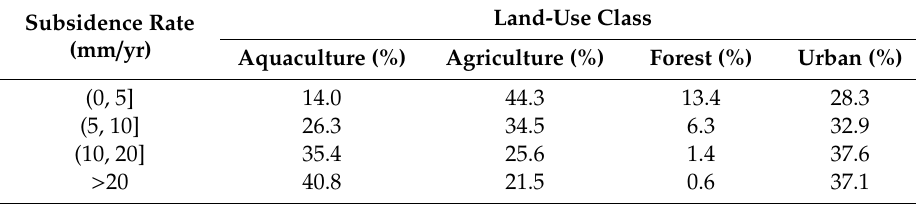
Table 4. Percentage of subsidence velocity ranges within each land-use